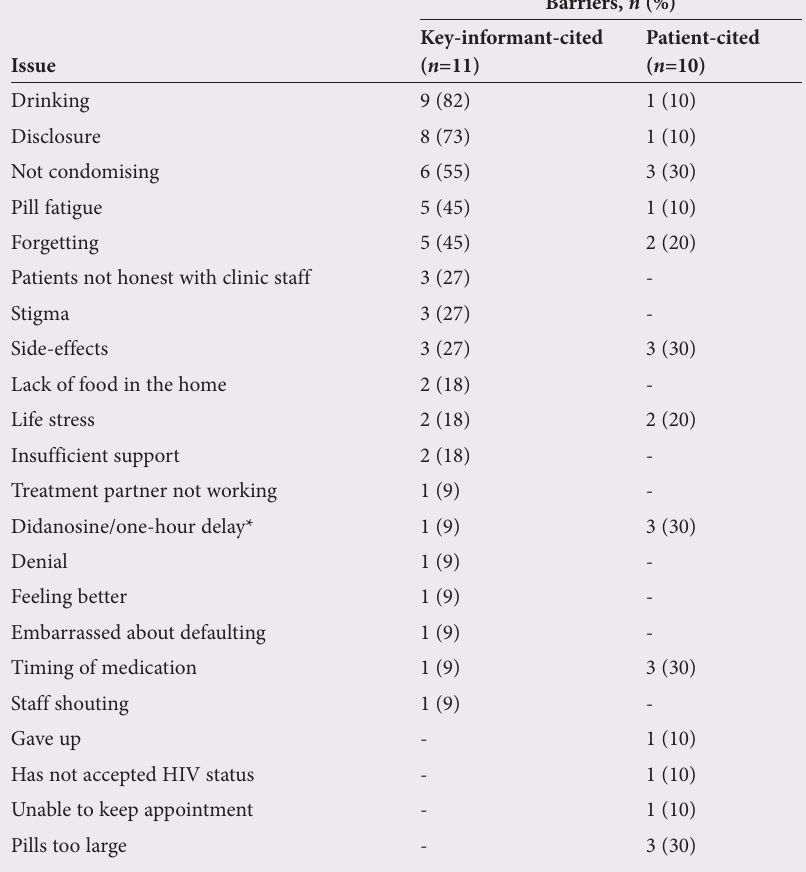
Table 1. Barriers to ART adherence cited patients and key